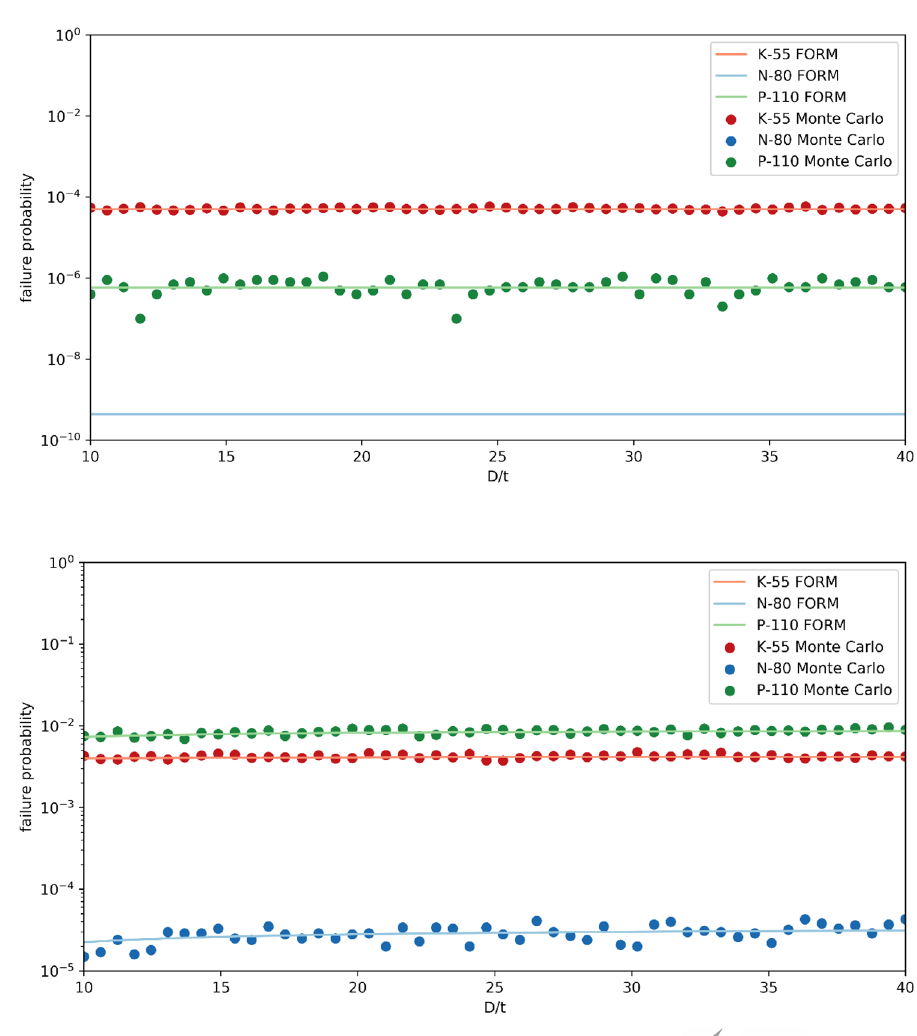
Fig. 5 Burst failure probabilities over D/t range